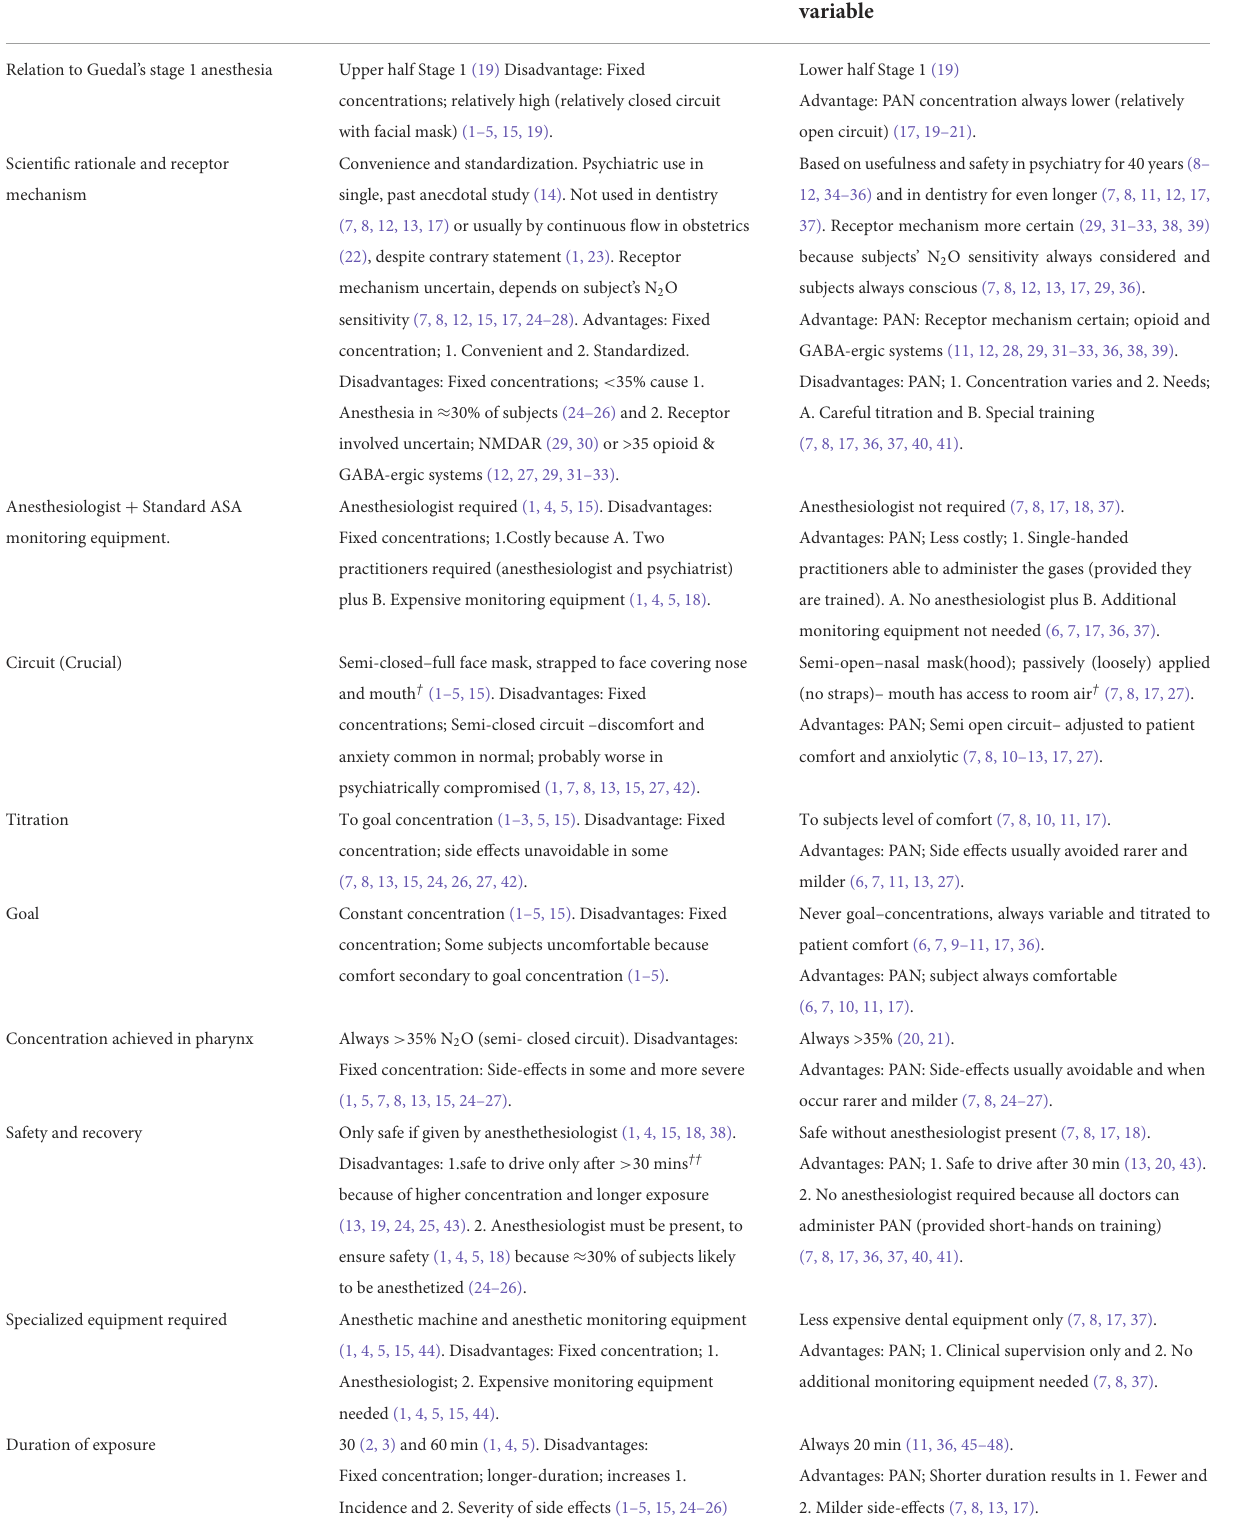
TABLE 1 Comparison of fixed and variable titrated (PAN) concentrations of subanaesthetic N 2 O for